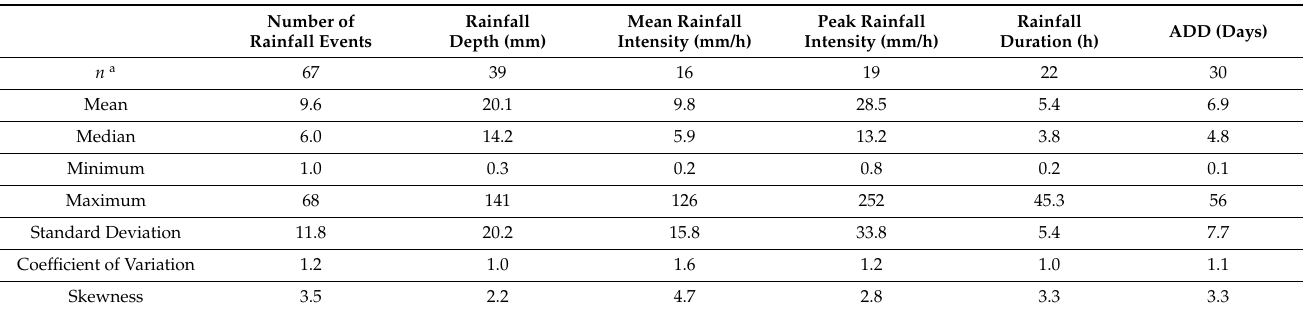
Table 2. Summary of rainfall characteristics on the study sites from the reviewed research articles related to first flush a